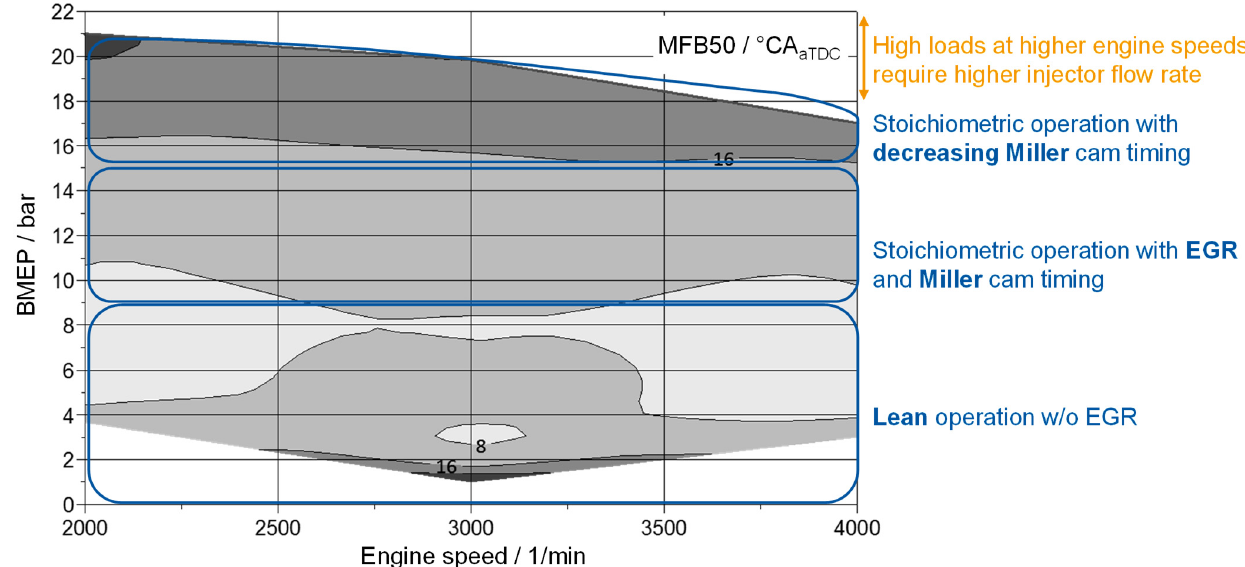
Figure 2. Engine operation strategy as result of previous thermodynamic investigations. The position of 50% fuel mass fraction burned (MFB50) shows an efficiency optimal operation for low and mediums loads, but a retarded combustion due to knocking at higher loads.